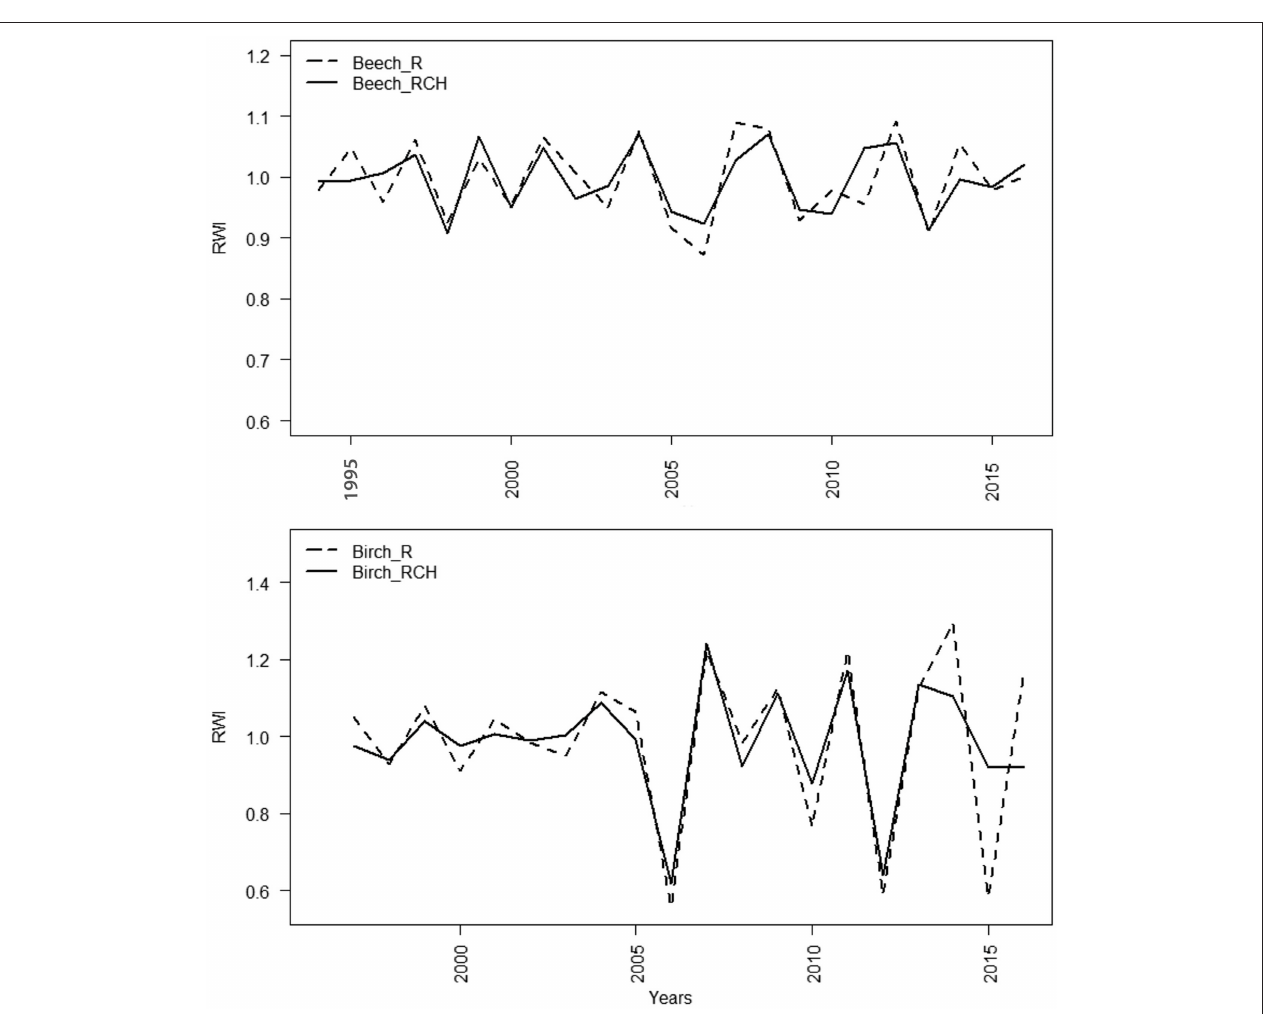
FIGURE 4 | Mean standardized TRW chronologies in reference and RCH plots for European beech (above) and silver birch (below). The “x” axis refers to the years. Dashed lines refer to European beech and silver birch trees grown on the reference plots (R) and the solid lines on the relic charcoal hearth (RCH) plots.